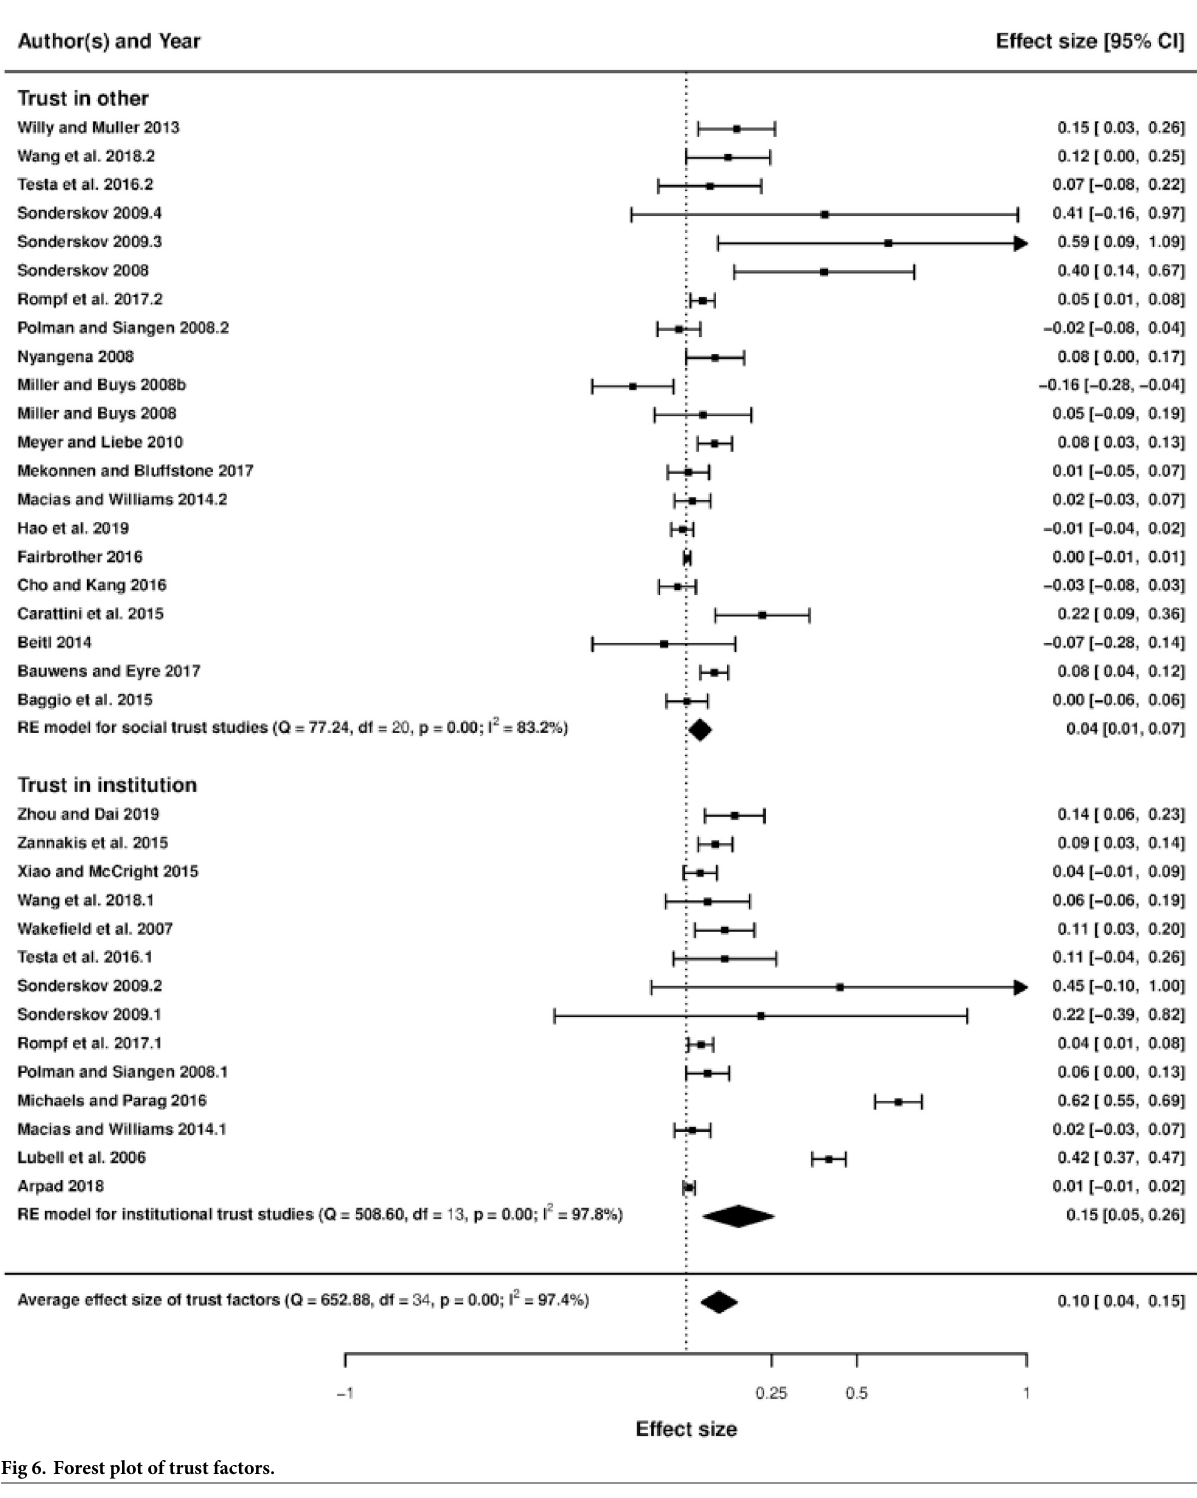
Fig 6. Forest plot of trust factors.